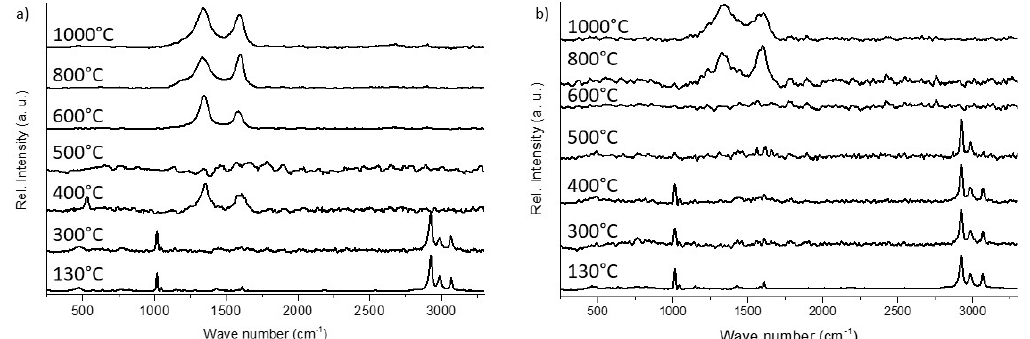
Figure 9. Raman microscopic analysis of the surface of crosslinked and pyrolyzed foams after pyrolysis at different temperatures. ( a ) Raman spectra of foams embedded, ground and polished as measured on the inner of the foam struts; ( b ) Raman spectra of the same foams, where the measurement position was on the outer surface of the foam struts.